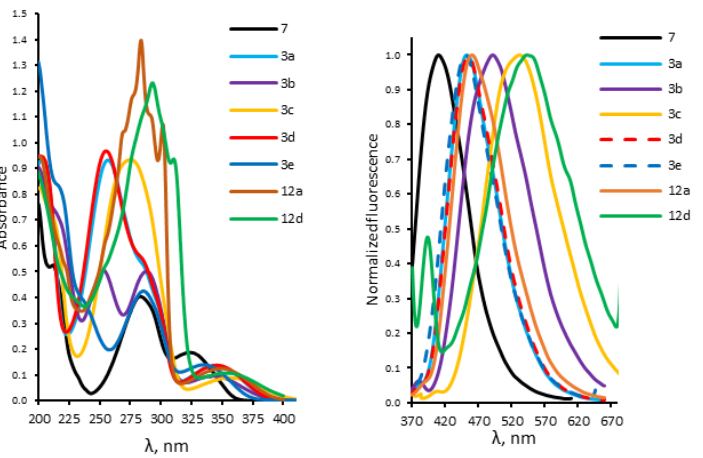
Figure 4. UV-VIS and normalized fluorescence spectra of 3a-b , 12a , and 12d phosphonocoumarins in acetonitrile.